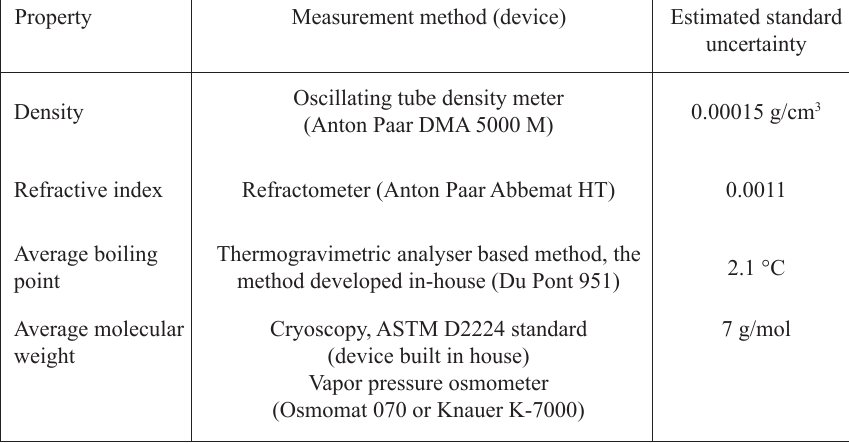
Table 1. Methods used for measuring the properties of shale oil samples